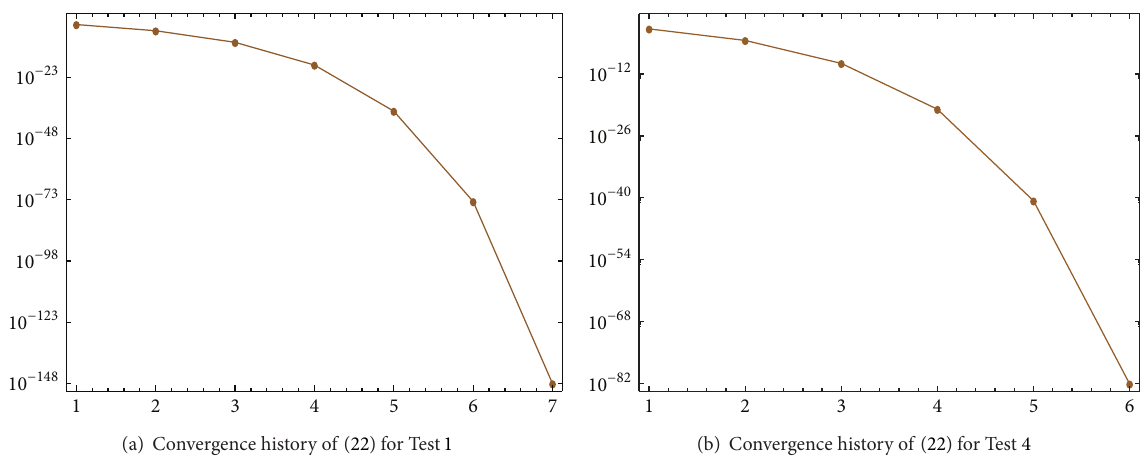
Figure 4: Using 𝛽 = 0.0001 in (22) so as to solve different